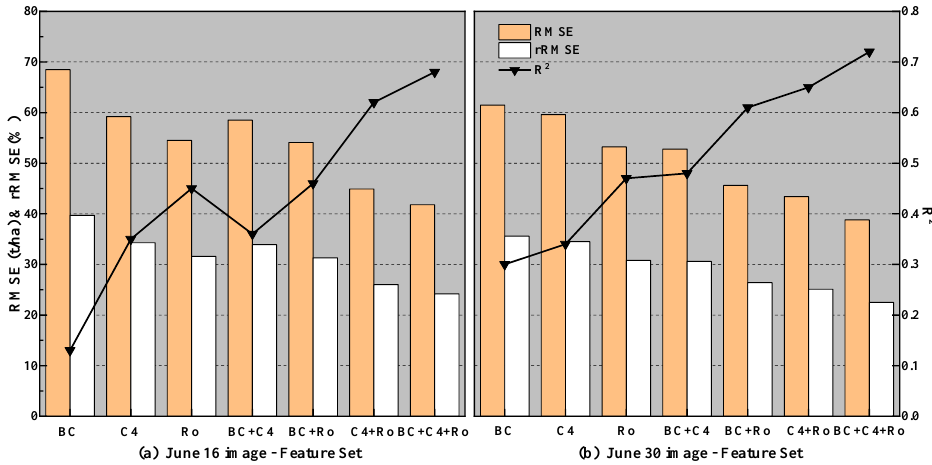
Figure 14. The results of mapped forest AGB with seven feature sets.